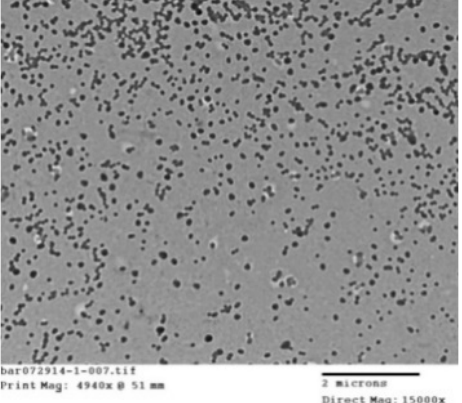
Figure 4. TEM image of poly(HEMA) nanoparticles prepared according to the formulation listed for sample A2 in Table 1.